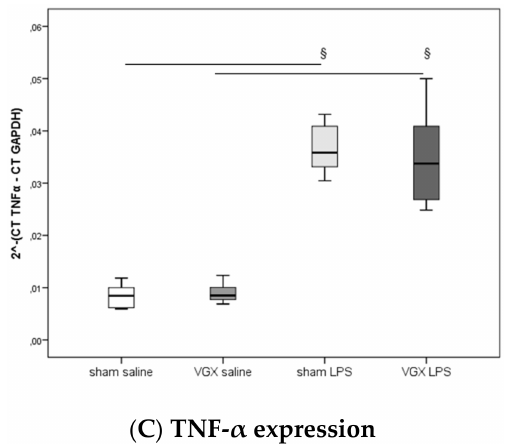
Figure 5. Cardiac proinflammatory mRNA expression (( A ) IL-1ß, ( B ) IL-6, ( C ) TNF- α ) at the end of the experiments. Data presented as normalized expression (median, IQR = Inter Quartile Range) at 4 h after LPS injection (T5). No significant effect of right cardiac vagus nerve resection was observed ( p > 0.05). Significant LPS effect ( § : sham LPS versus sham saline and VGX LPS versus VGX saline, p ≤ 0.001) was detected in all tissue proinflammatory cytokine mRNA levels measured. The circles present